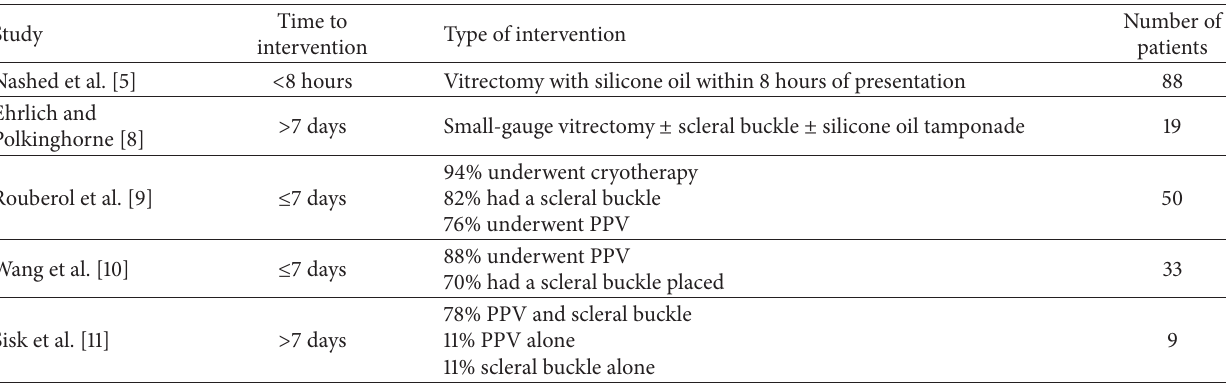
Table 1: Time to and type of intervention.